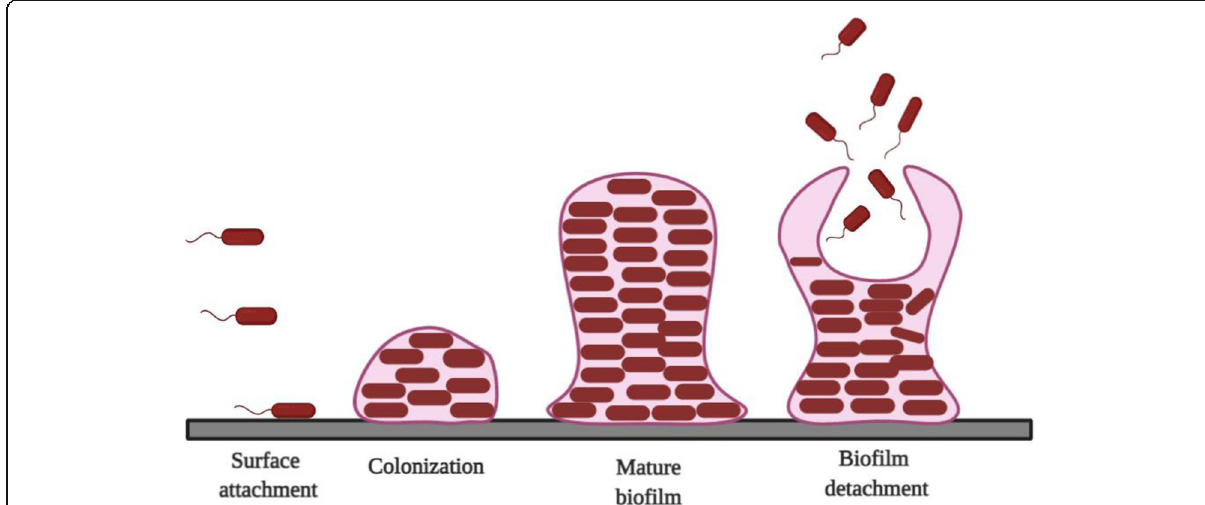
Fig. 1 Diagrammatic representation of stages involved in biofilm formation. Stage 1: reversible attachment of bacterial cells to the surface; stage 2: production of the extracellular EPS matrix and early development of biofilm architecture; stage 3: maturationof biofilm architecture; stage 4: detachment bacterial